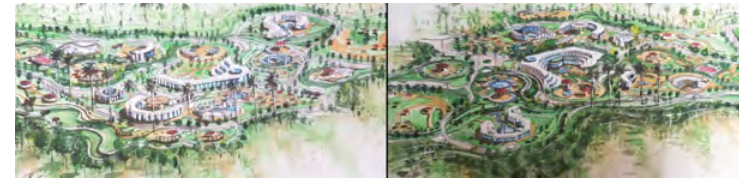
Figure 12. Eastern and western perspective view of the proposed park design (Source: Author).